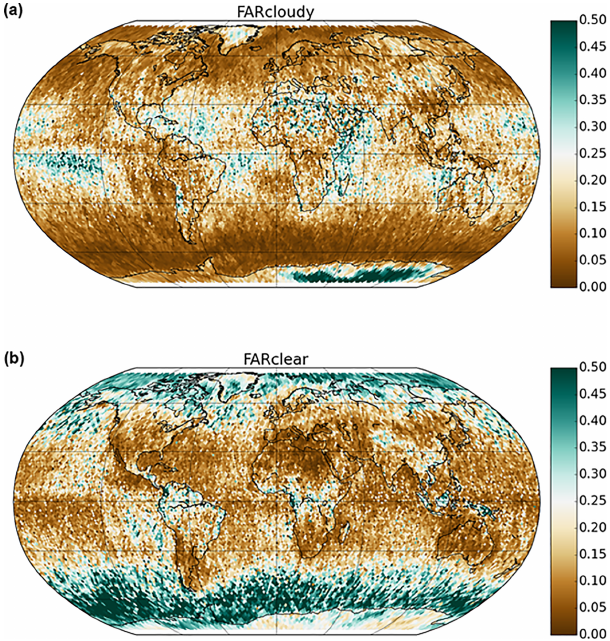
Figure 11. False alarm rates for cloudy (a) and clear (b) predictions for the CLARA-A2 cloud mask achieved after filtering the CALIOP cloud mask with the cloud optical thickness value of 0.225. Same underlying matchup data set as in Fig. 2. Results are presented in a Fibonacci grid with 75km